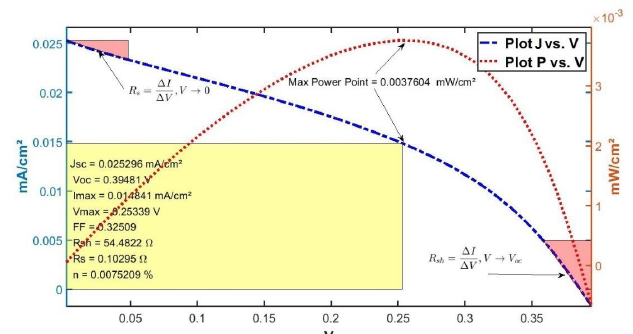
Figure 11. I – V curves for CdS / CdTe solar cells without addition of PANI. Source: the